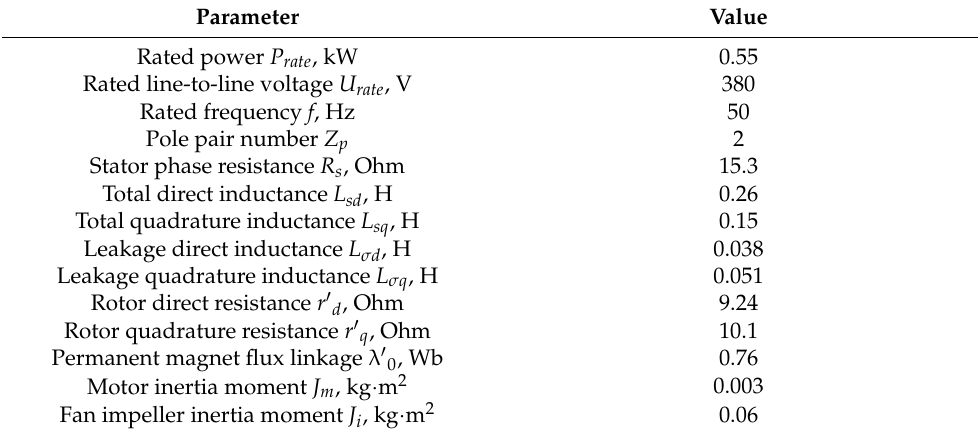
Table 1. LSPMSM parameters.